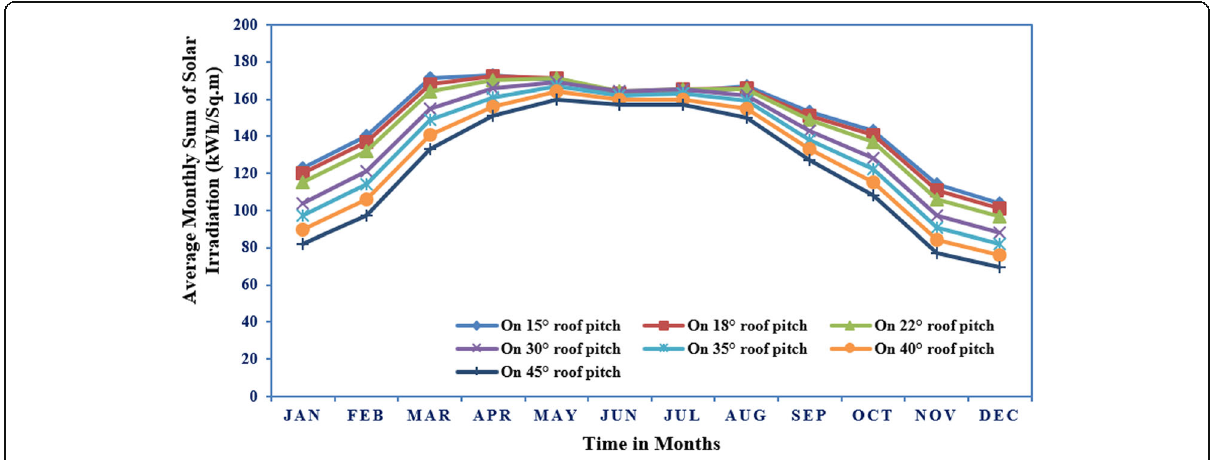
Fig. 5 The average monthly sum of global solar irradiation